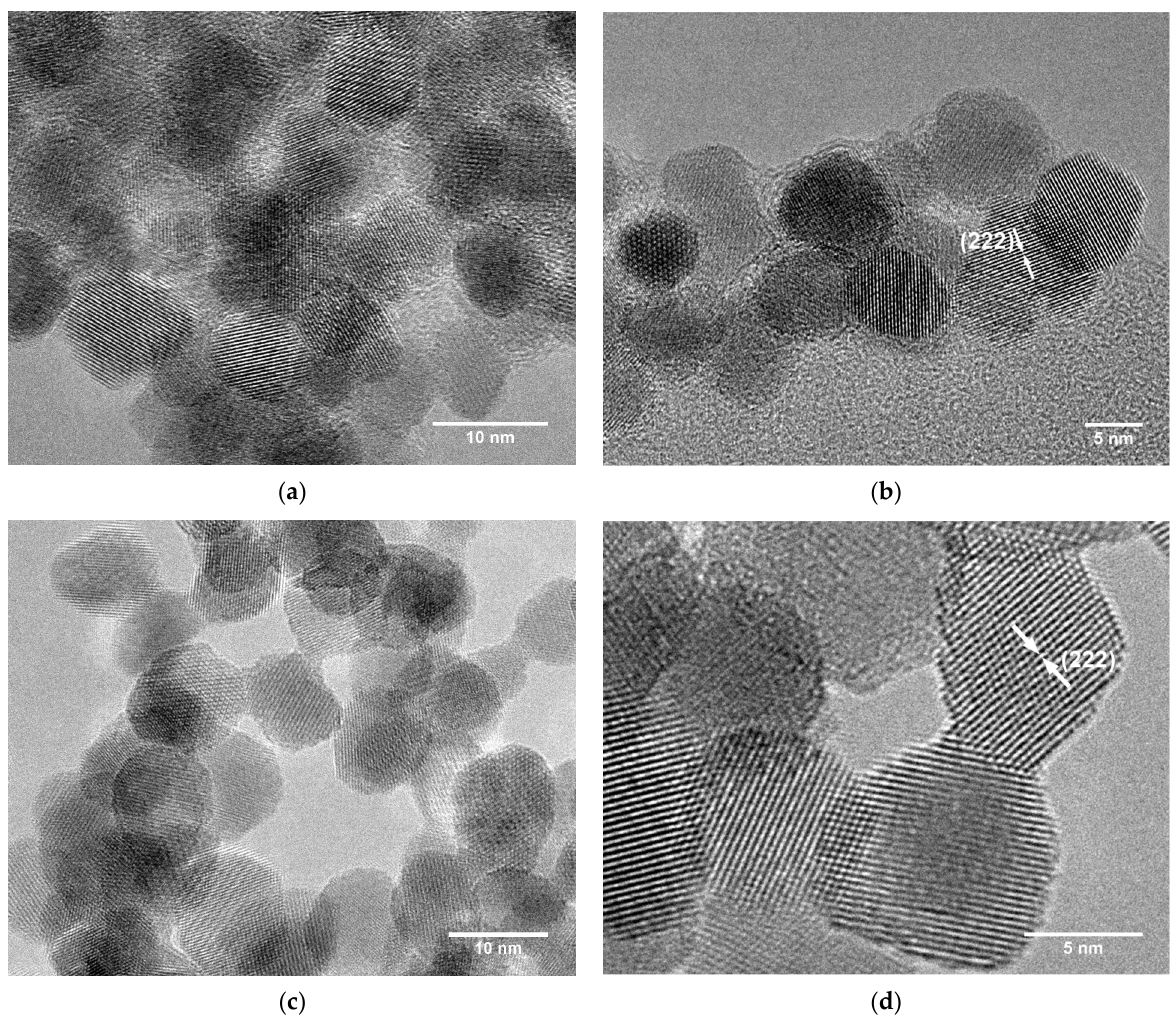
Figure 10. HRTEM micrographs of the primary nanoparticles in ITO aerogel B samples as obtained directly after CPD ( a , b ) and after annealing at 400 °C for 2 h in air ( c , d ) at di ff erent magni fi cations.